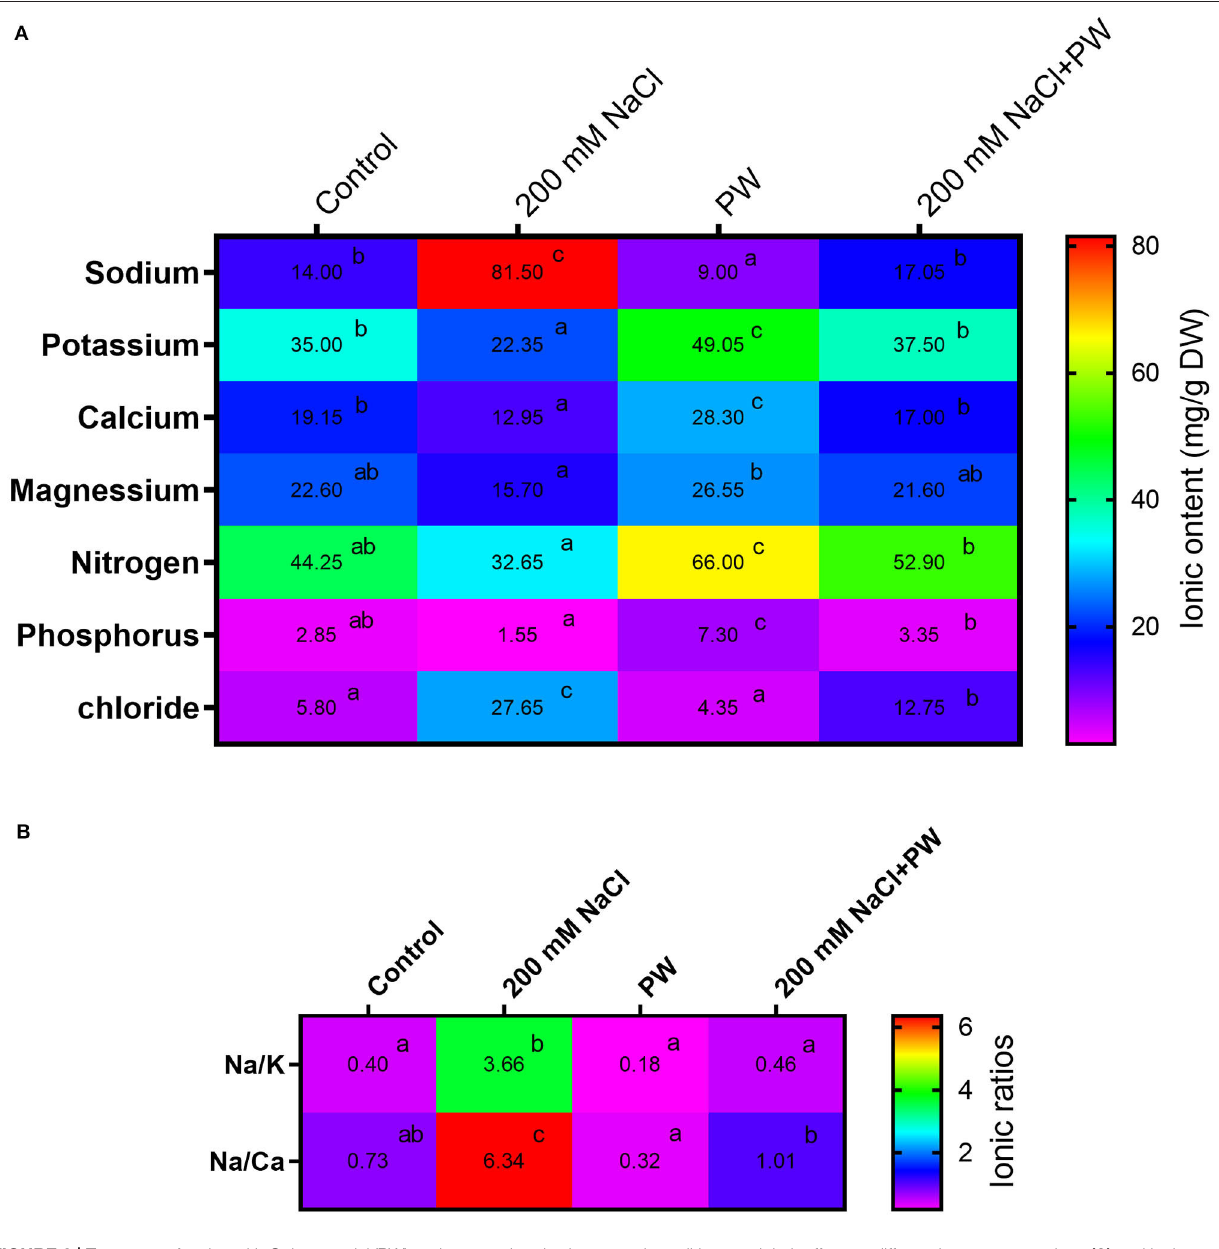
FIGURE 6 | Treatment of maize with S. lycopersici (PW) under normal and salt-stressed conditions and their effect on different ions concentrations (A) and ionic rations (B) . Bars indicate mean ± standard error from three replicates at a significant level of p ≤ 0.05. Significant differences are represented by superscript letters at p ≤